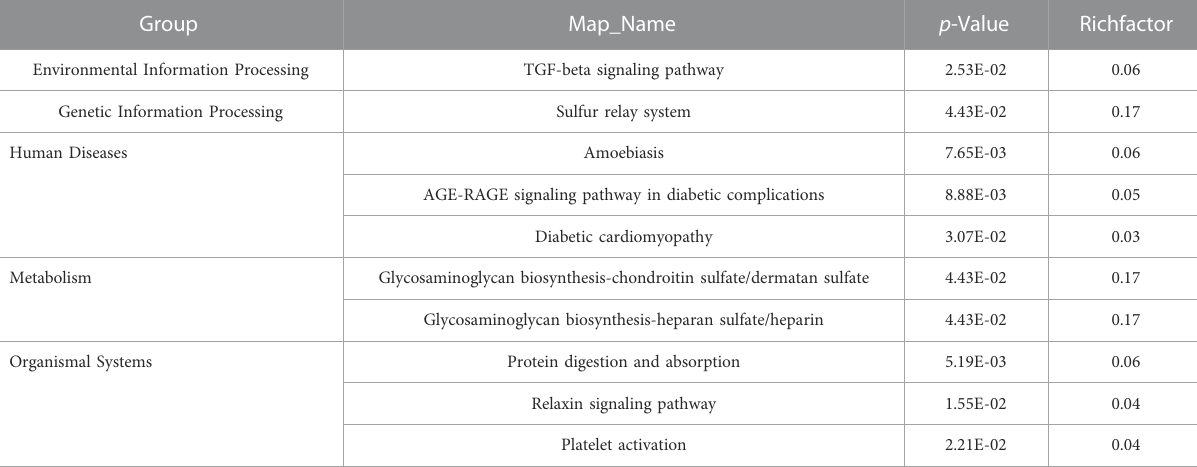
TABLE 1 KEGG pathway enrichment analysis of those 57 signi fi cantly changed